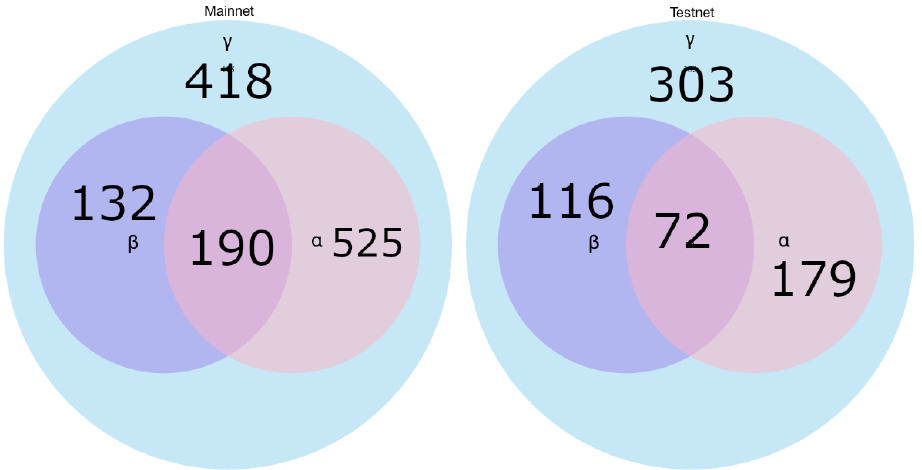
Figure 10. Venn diagram of channel sets in interval